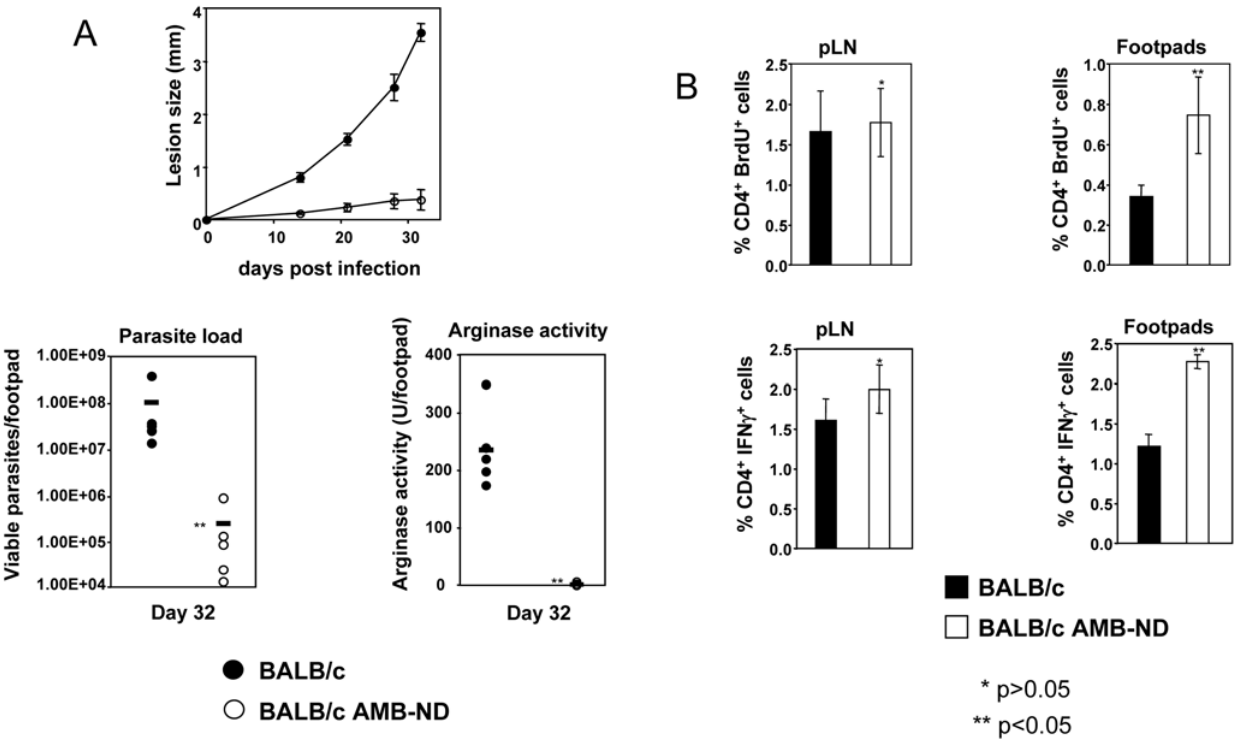
Figure 4. Control of disease in BALB/c mice correlates with downregulation of arginase and restoration of immune responses. Two groups of BALB/c mice (n=5) were infected with L. major parasites in one hind footpad and one group was injected i.p. with 5 mg/kg of AMB-ND on day 1, 2, 7, 14, 21 and 28. (A) The lesion development was monitored at weekly intervals and five weeks post infection, number of viable parasites and the arginase activity was measured in individual footpads. (B) % of CD4 + BrdU + T and % of IFN- c -expressing CD4 + T cells in individual popliteal lymph nodes and lesions (pool of at least 2 footpads), error bars represent standard deviations. Data show the results of one representative experiment out of two independent